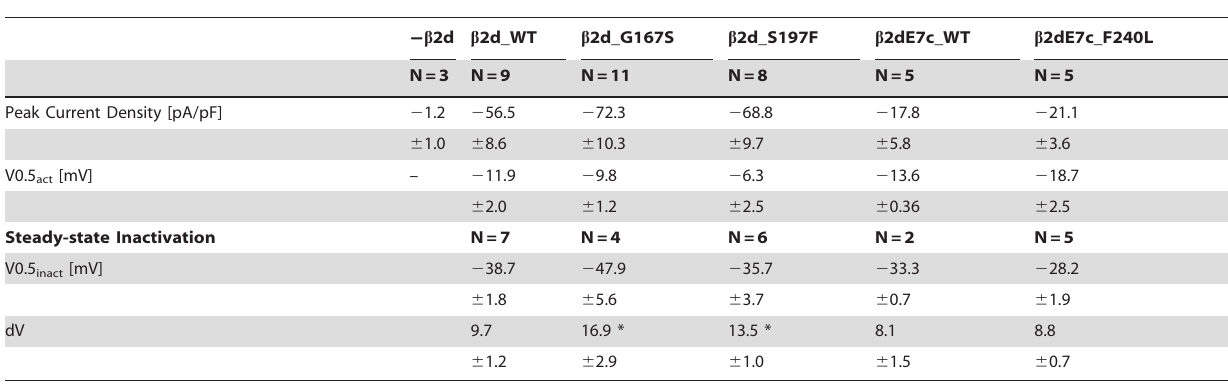
Table 2. Current and voltage parameters (mean 6 SEM) of the constructs